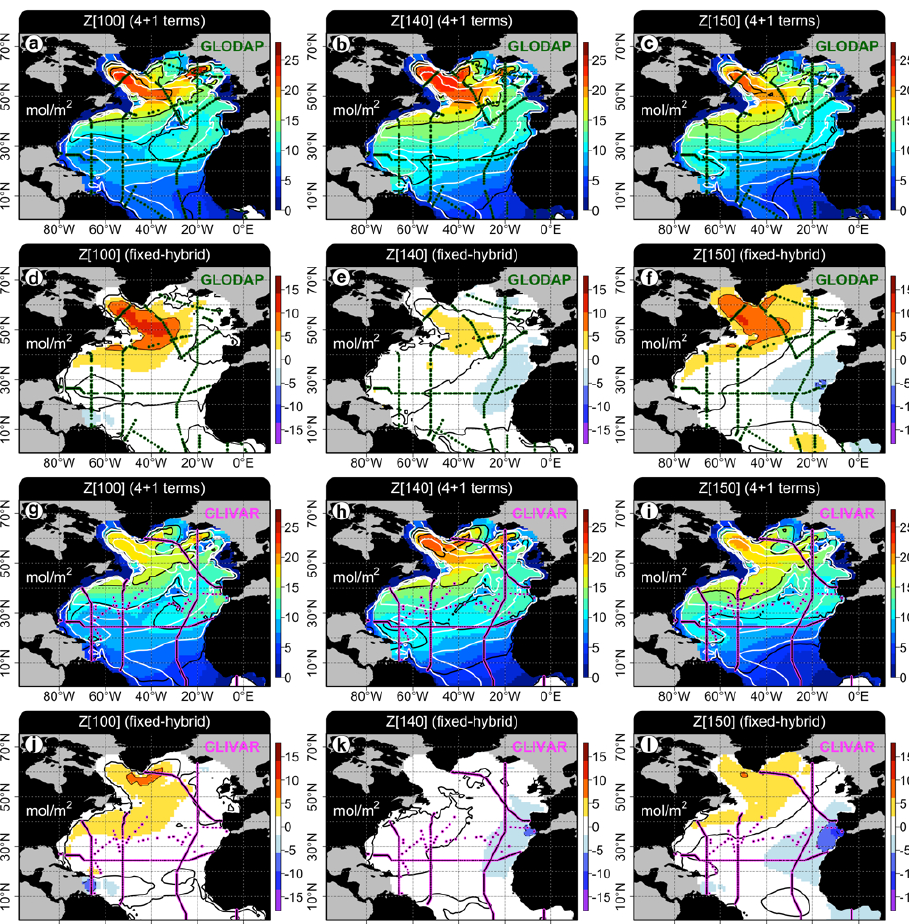
Fig. 13. Mapped anthropogenic carbon column inventory changes calculated from sampling networks that do not change in time ( 1C fixed (a, g) Z 100 , (b, h) Z 140 and (c, i) Z 150 . In these panels, black contours are drawn every 5molm − 2 ; white contours reproduce the shape in Fig. 1b. Differences between the fixed and hybrid cases ( 1C fixed contours drawn every 6molm − 2 with a thick line at 0molm − 2